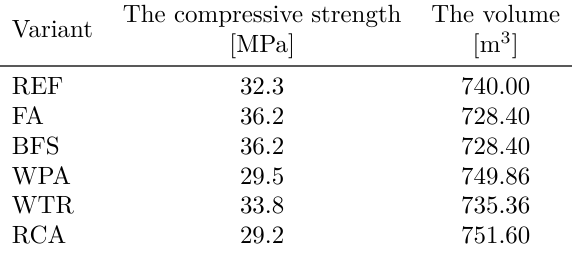
Table 3. The compressive strength of the concrete and volume of ă concrete for designed